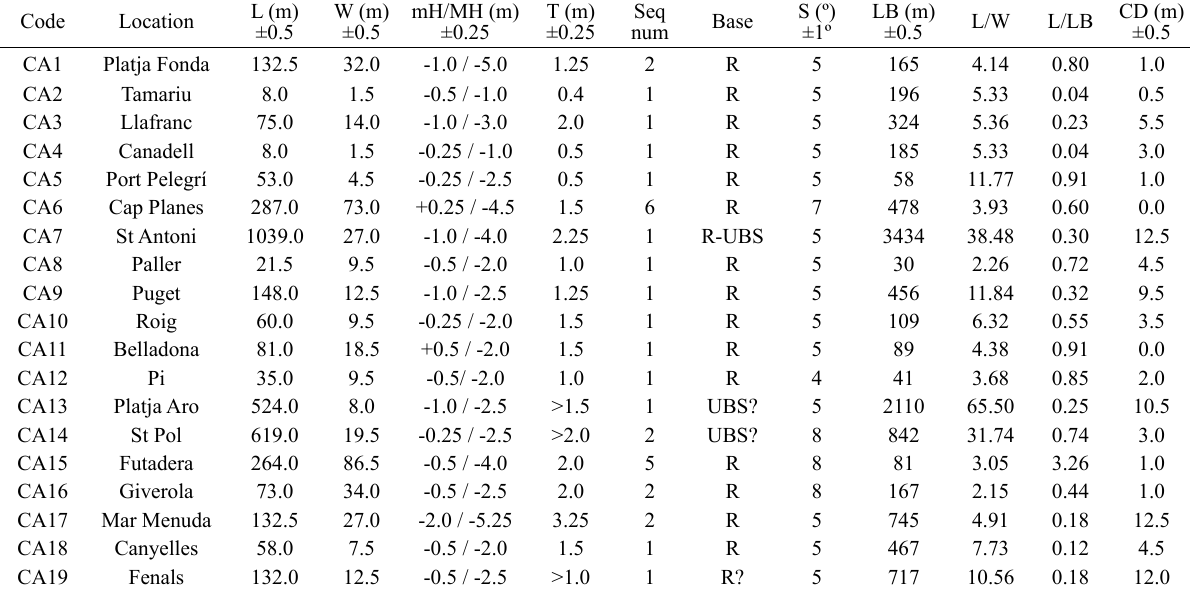
Table 1. – Morphometric characteristics of the beachrocks: length (L) and width (W) (maximum measured values); depth (D) (negative values refer to depth below MSL); thickness (T); number of differentiated ledges (sequences) of beachrock (seq. num.); base (substratum at the base of beachrock: R=rock; UBS=unconsolidated beach sediments); slope towards the open sea (S); length of the current beach on which the beachrock is located (LB); beachrock length/width ratio (L/LB); coastal distance (CD) is the minimum distance between shoreline and outcropping